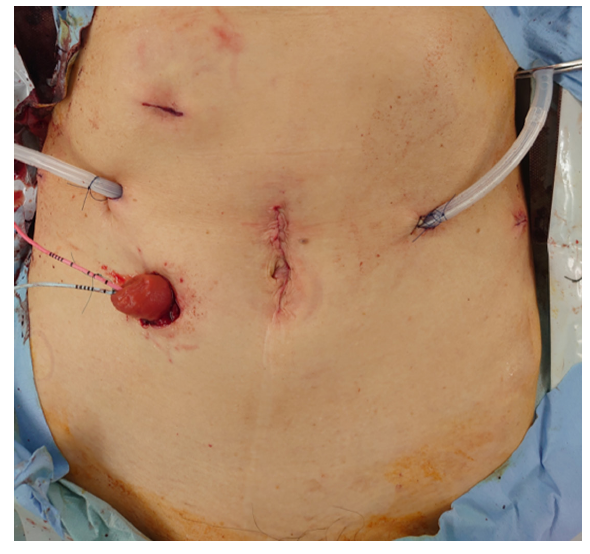
Figure 6. Abdominal wound findings immediately after surgery.